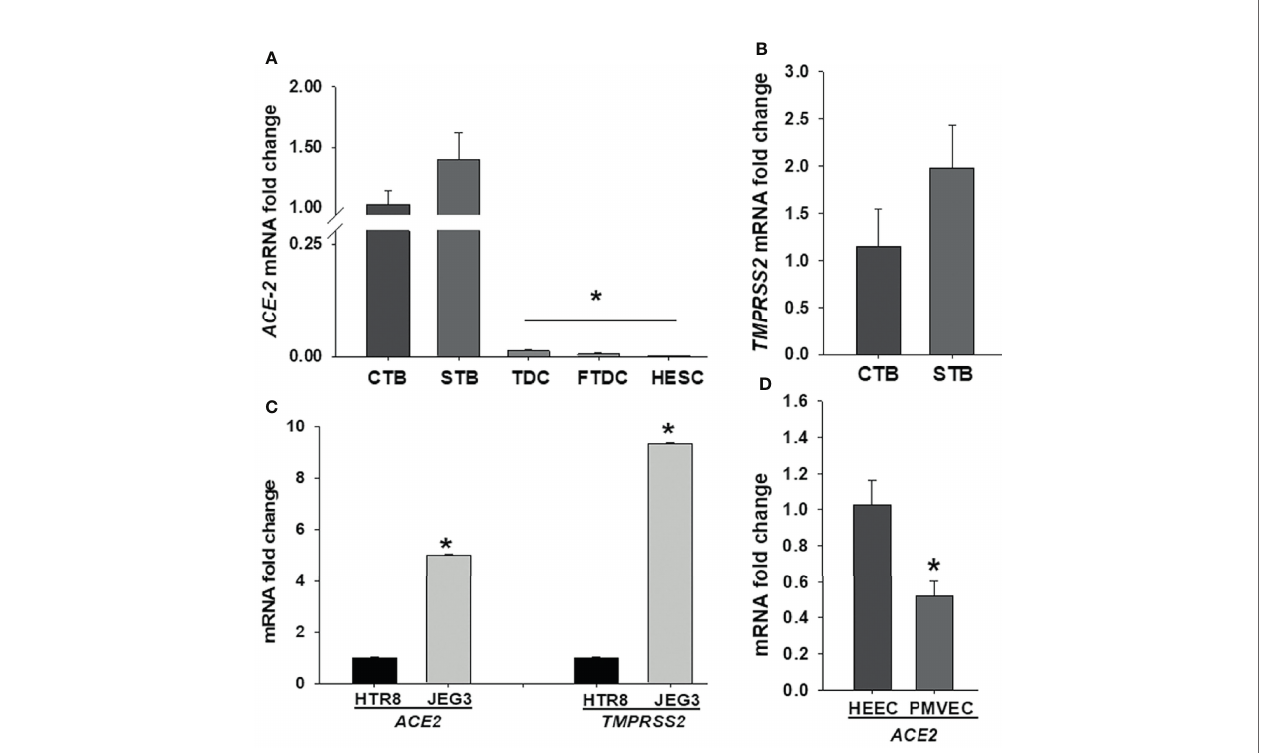
FIGURE 1 | Comparison of SARS-CoV-2 entry receptor ACE2 and TMPRSS2 mRNA levels among various decidual (maternal) and placental (fetal) cell types at the maternal-fetal interface. Expression levels of ACE2 (A) and TMPRSS2 (B) in human term cytotrophoblast (CTBs), syncytiotrophoblast (STBs), term decidual cell (TDCs), fi rst trimester decidual cell (FTDCs), and human endometrial stromal cell (HESCs) cultures; Expression levels of ACE2 and TMPRSS2 in trophoblastic cell lines HTR8 and JEG3 (C) ; as well as expression levels of ACE2 in placental microvascular endothelial (PMVECs) and human endometrial endothelial cell (HEECs) cultures (D) by qPCR. Bars represent mean ± SEM, n=4; * P<0.05 vs. CTB or STB (A) ; * P<0.05 vs. HTR8 (C) ; * P<0.05 vs. HEECs (D)